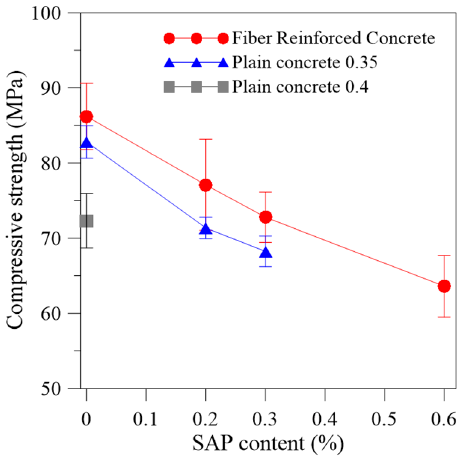
Figure 5. Compressive strength results at 28 days of the fiber reinforced concrete of the w/c (basic) of 0.35; plain concrete without fiber reinforcement with the w/c (basic) of 0.35, and the plain concrete without fiber reinforcement with the w/c (basic) of 0.40. Table 3. Mechanical properties of the high strength concrete and steel fiber reinforced concrete. Mean Compressive Mixture Strength